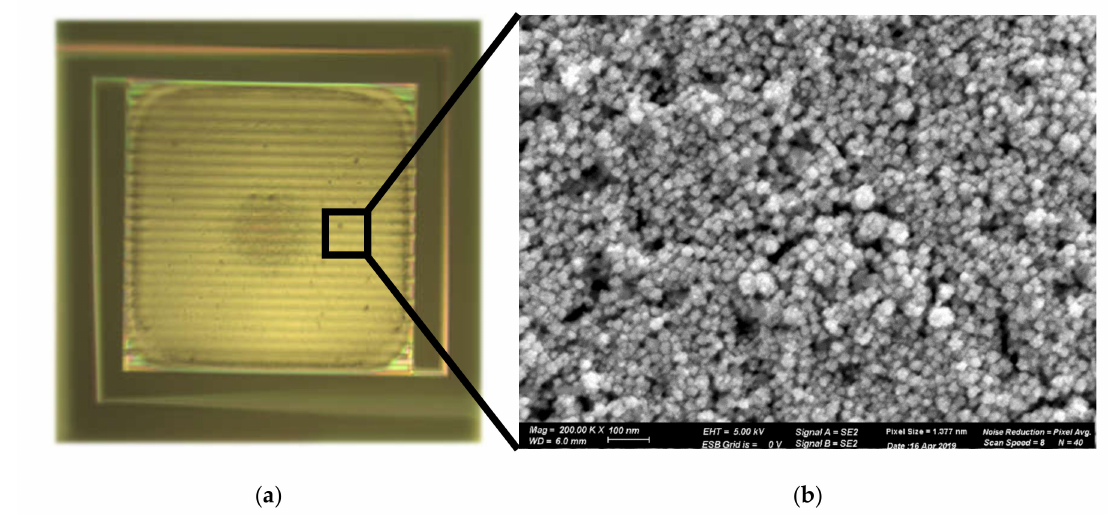
Figure 5. Pt nanoparticle catalytic-layer characterization: ( a ) Optical image of pixel with catalyst printed on top of it; ( b ) SEM micrograph of catalytic